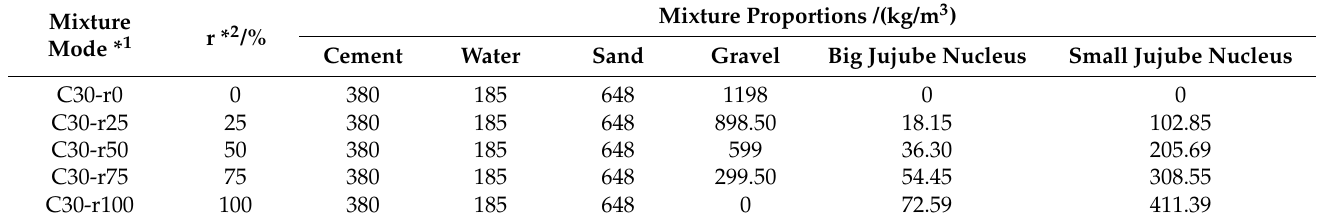
Table 3. Concrete mixture proportions in 1 m 3